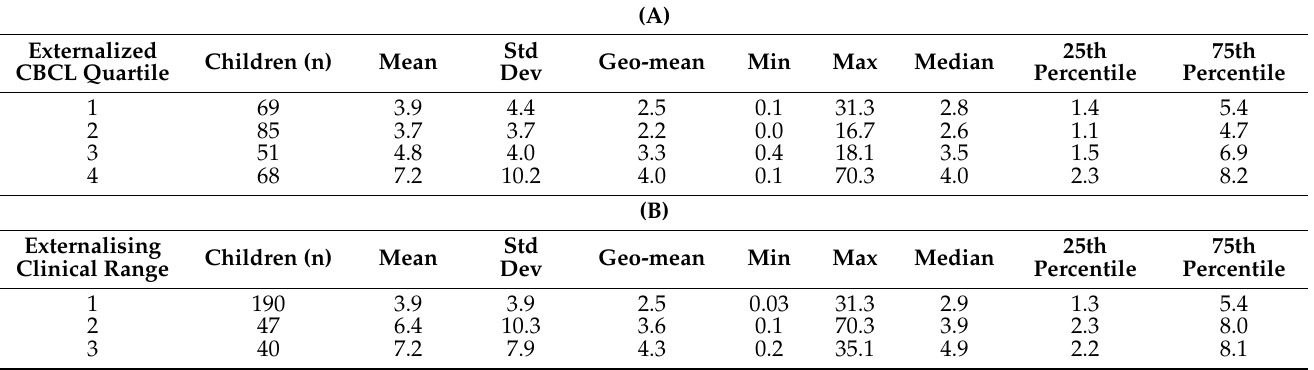
Table 1. Distribution of Mn by quartile group of externalizing CBCL scores of Pacific Island Fam- ilies (PIF) 9-year-old children ( µ g/g, dry weight) and by clinical defined group (normal/within clinical